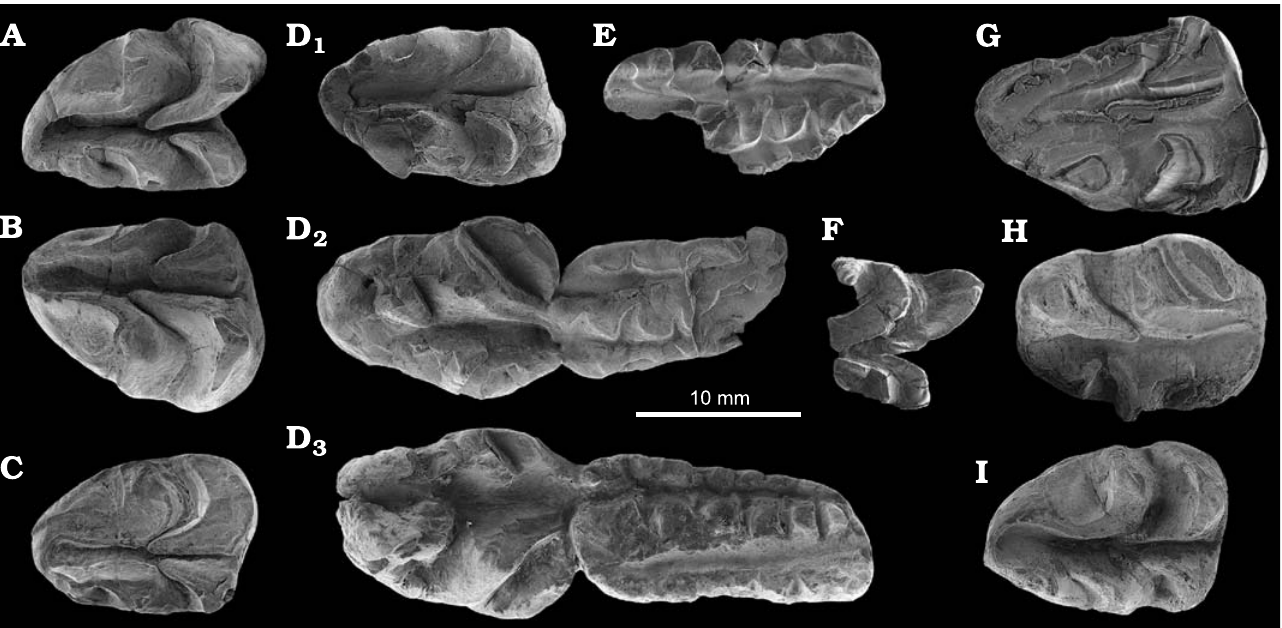
Fig. 8. Occlusal views of molars of multituberculate mammal Sphenopsalis nobilis Matthew, Granger, and Simpson, 1928 from the upper Paleocene Nomogen beds at the Erden (Urtyn) Obo locality, Inner Mongolia, China . A . IVPP V19037, right m2. B . IVPP V19030, left m2. C . IVPP V19028, right m2. D . IVPP V19029, right m2 (D 1 ), right M1–2 (D 2 ), left M1–2 (D 3 ). E . IVPP V19025, right M1, which belongs to the same individual as in Fig. 4. F . IVPP V19027, a developing right m2? G . IVPP V19033, a deeply worn left m2. H . IVPP V19026, right M2. I . IVPP V19036, right